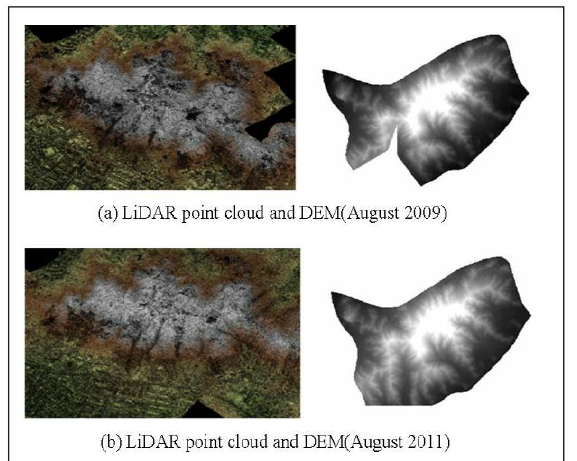
Figure 6. Airborne LiDAR data obtained before and after the debris flow